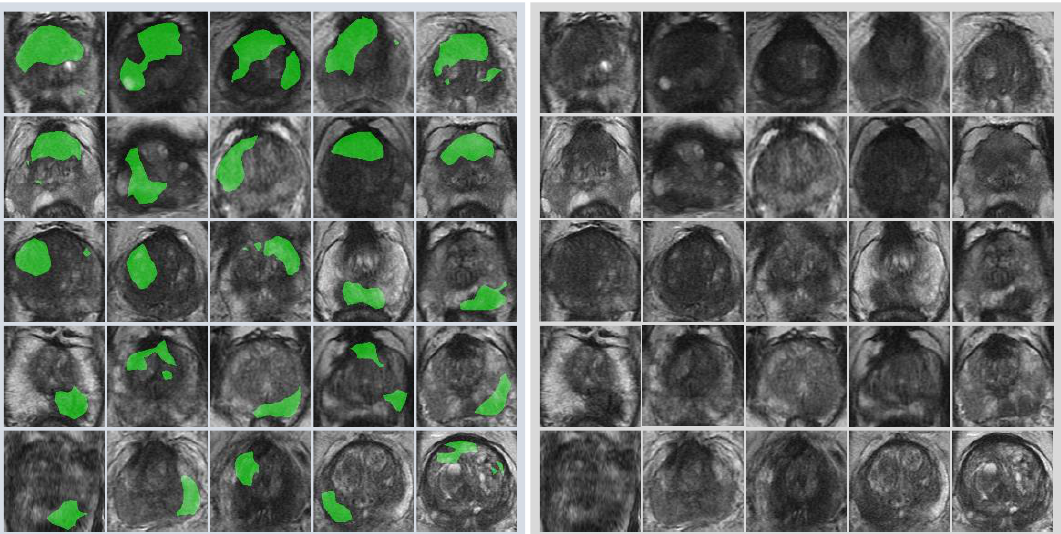
Figure 5. Representative images with overlapping areas between deep learning-focused regions and genuine cancer locations. Left image group: 25 images with overlapping areas between deep learning-focused regions and genuine cancer locations. The overlapped areas are colored in green. Right image group: corresponding 25 raw MR images. MR images = Magnetic resonance images.